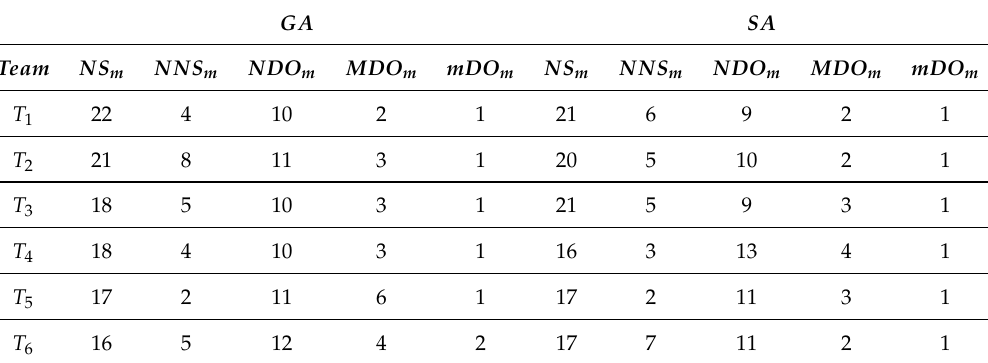
Table 12. Detailed analysis of the GA and SA physician schedule for September.